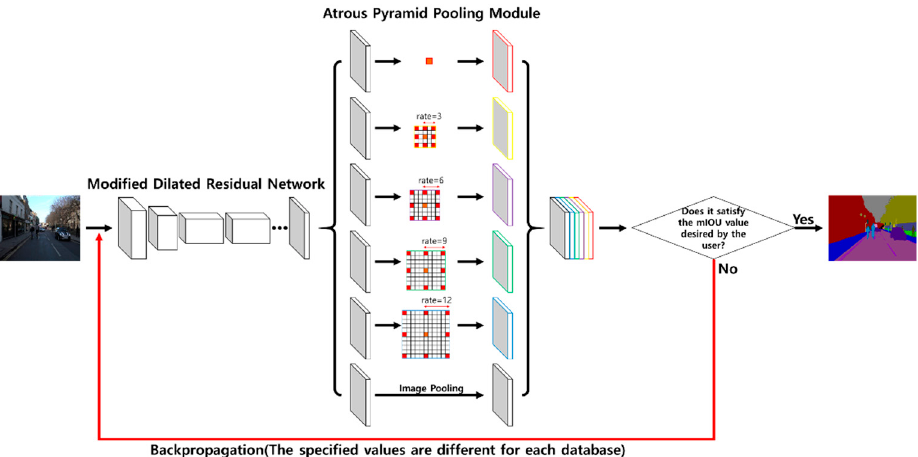
Figure 9. Structure of the backpropagation applied in this study.